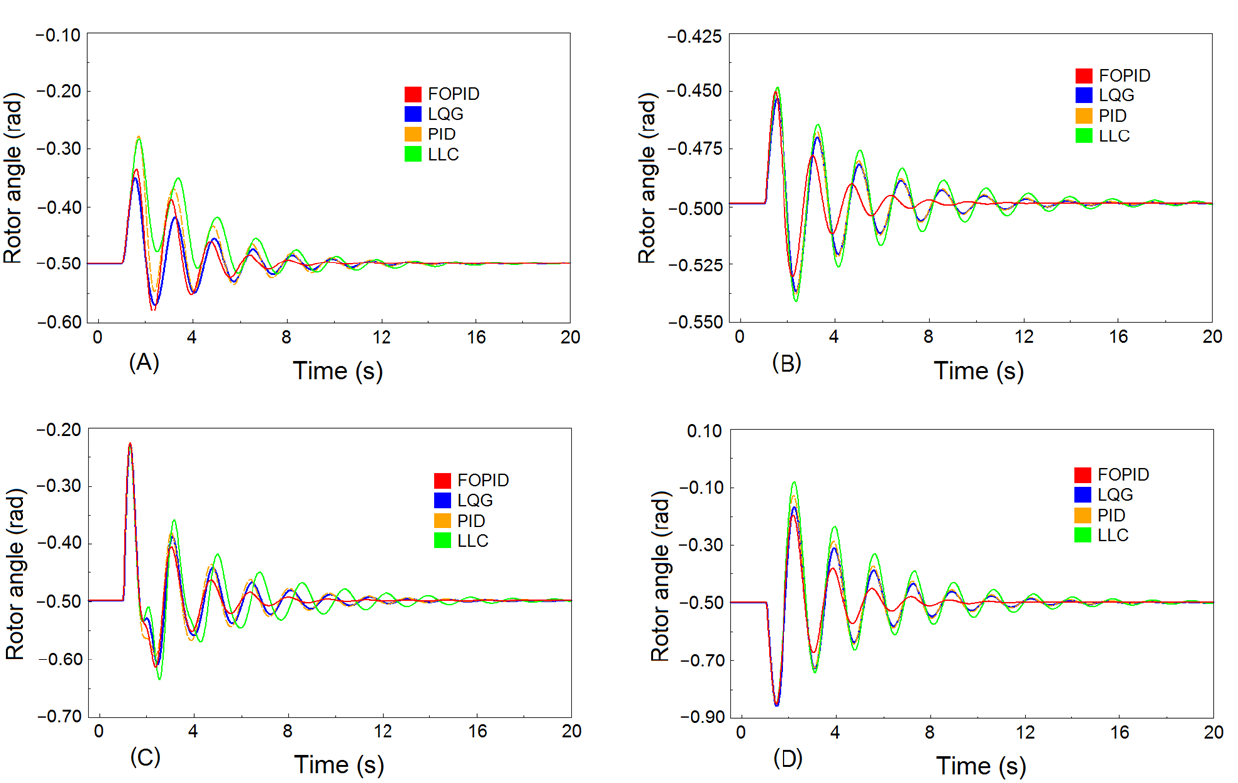
Figure 11. Rotor angle of generator G1 for scenario 1: ( A ) state 1, ( B ) state 2, ( C ) state 3, and ( D ) state 4.